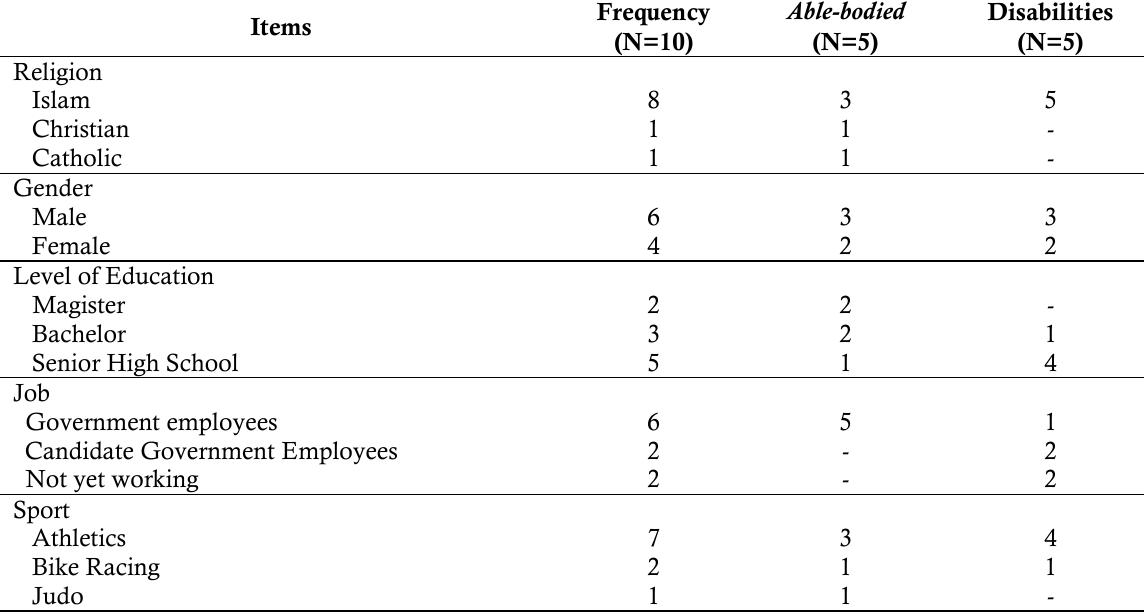
Table 2 <Participant